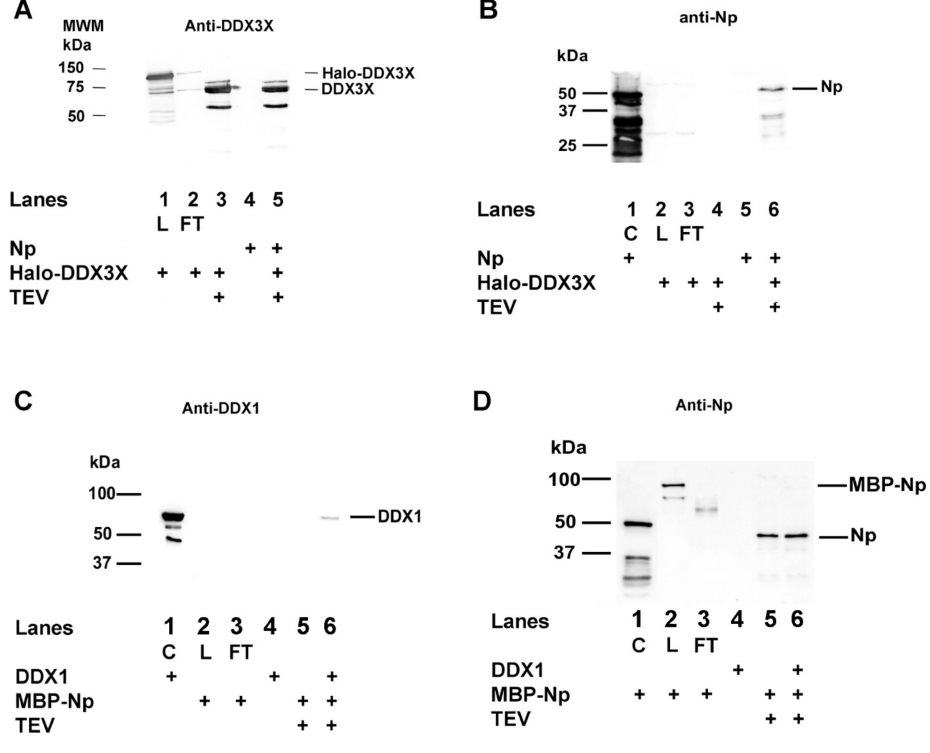
Figure 5. Np protein physically interacts with human DDX3X and DDX1. ( A ). Western blot with anti-DDX3X Abs of the fractions eluted from the HALO affinity beads with TEV protease. Lane